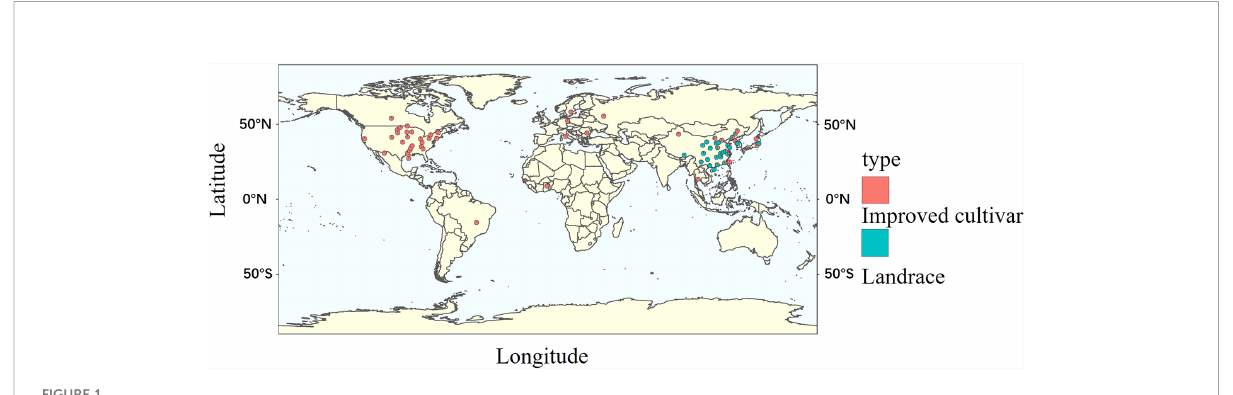
FIGURE 1 The geographical distribution of the tested